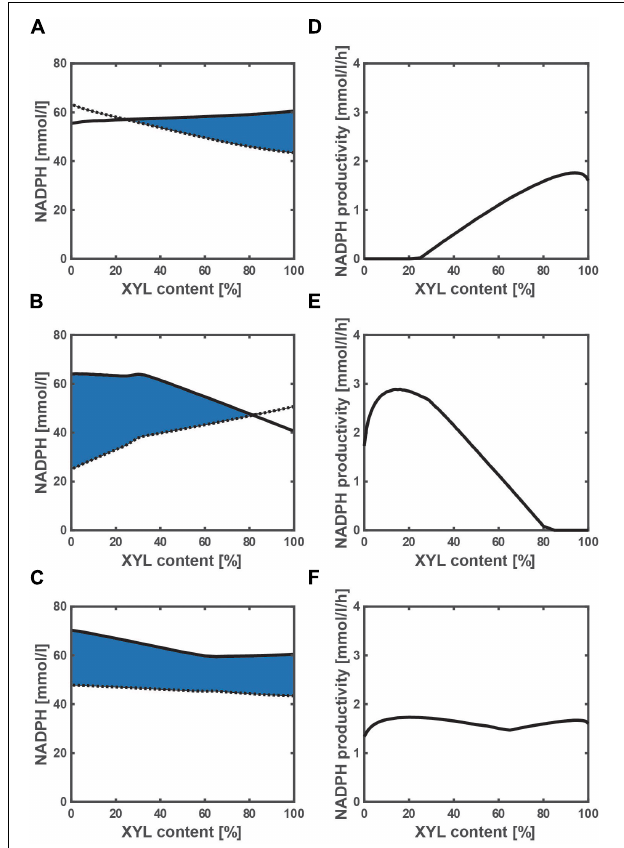
FIGURE 4 | Effect of the change in xylose content on the NADPH availability and NADPH productivity in wild type (A,D) , pgi mutant (B,E) , and ptsG mutant (C,F) grown on a mixture of glucose and xylose. (A–C) The solid and dotted lines represent the total NADPH production as expressed by Eq. (6) and the NADPH required for the biosynthesis as expressed by Eq. (9), respectively. The area surrounded by the solid and dotted lines as colored in blue is the extra NADPH that can be used for the useful metabolite production (i.e., NADPH availability). The xylose content [%] is defined as the ratio of xylose contained in a mixture of glucose and xylose. The total substrate concentration is 10